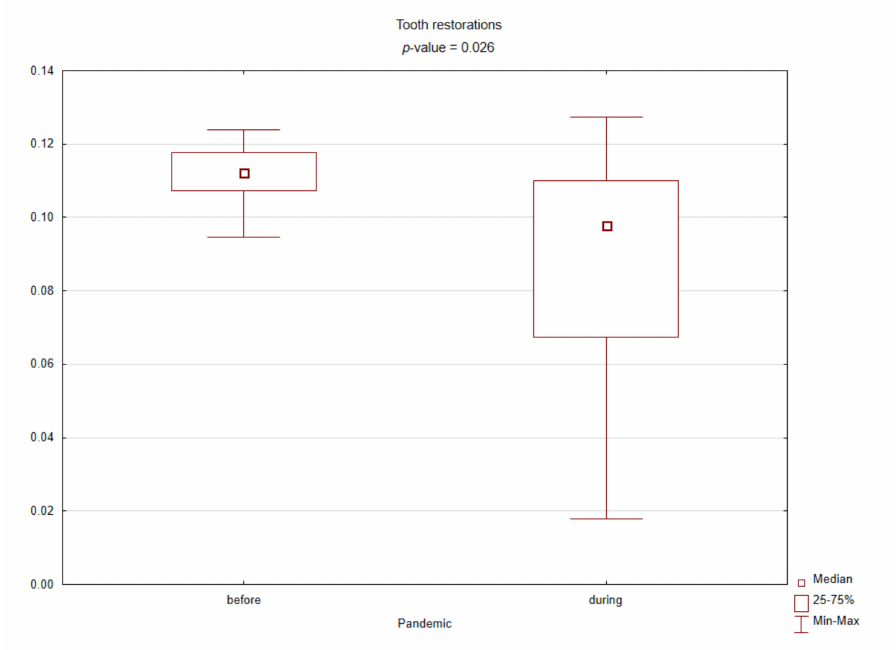
Figure 2. Box plot for the standardized number of tooth restorations before and during the COVID-19 pandemic ( p -value < 0.05 according to the Mann–Whitney test).